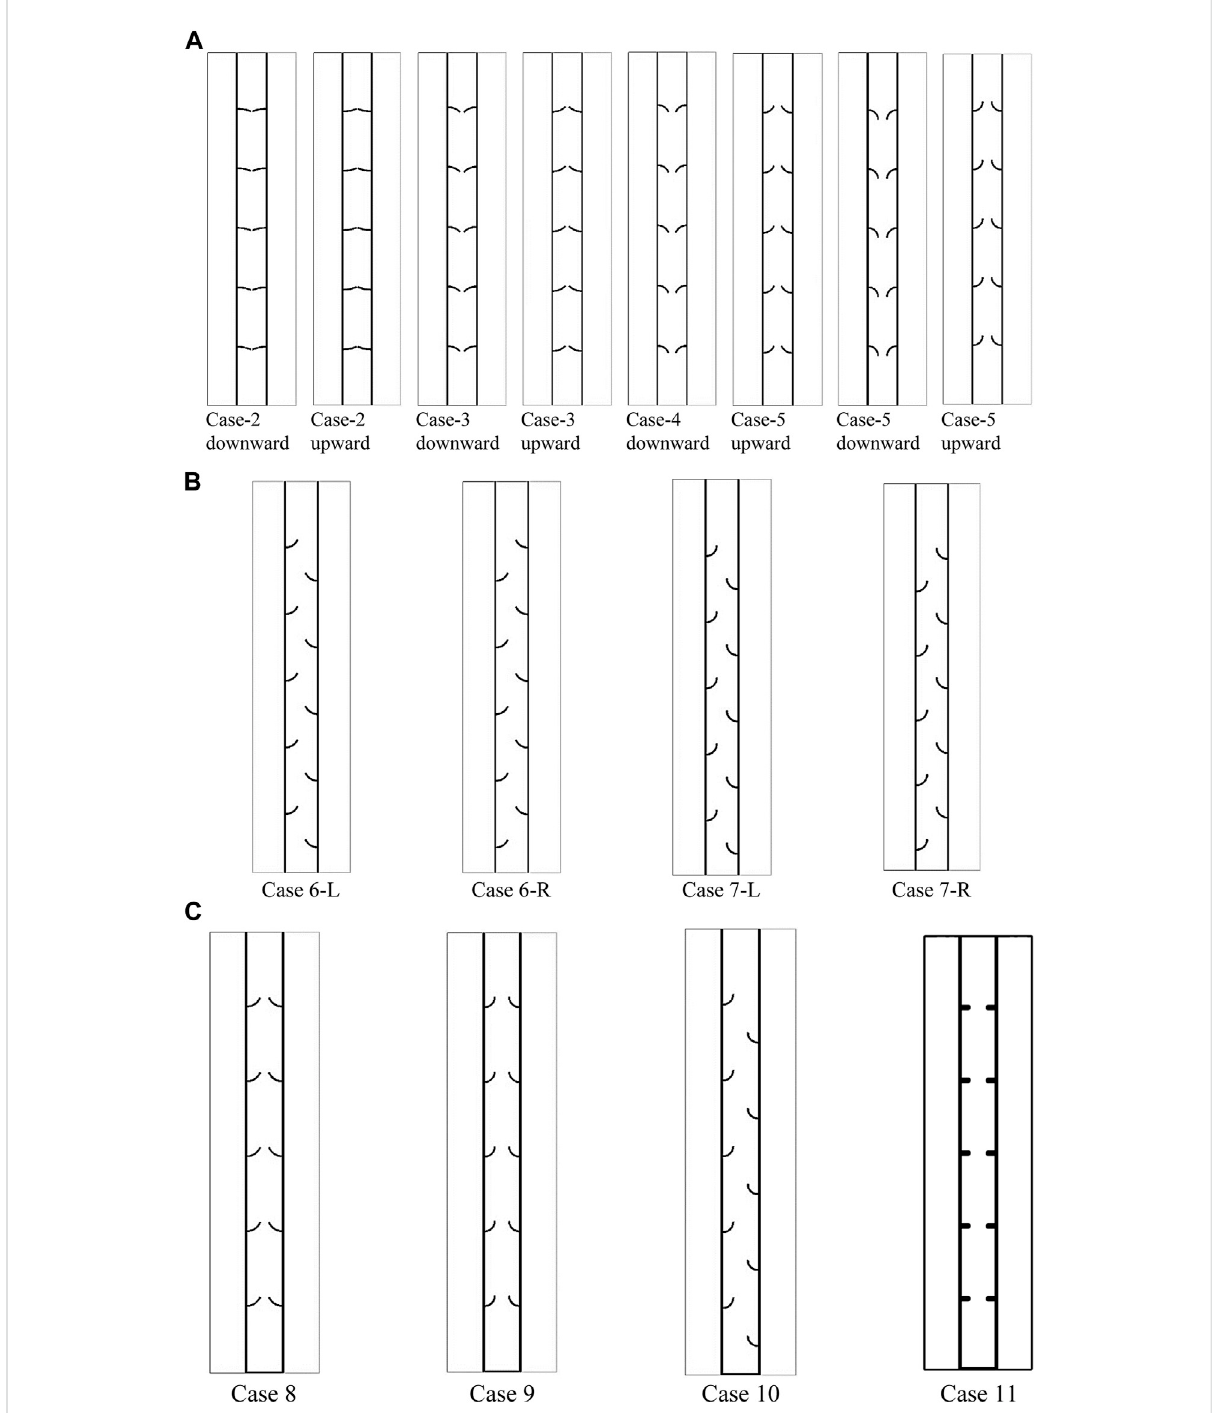
FIGURE 2 Schematic of the system with an arc-shaped fi n (A) using different angles of 22.5, 45, 67.5, and 90 ° and different directions of downward and upward; (B) using different staggered arrangements for the fi ns; and (C) using an added fi n to the bottom of the heat